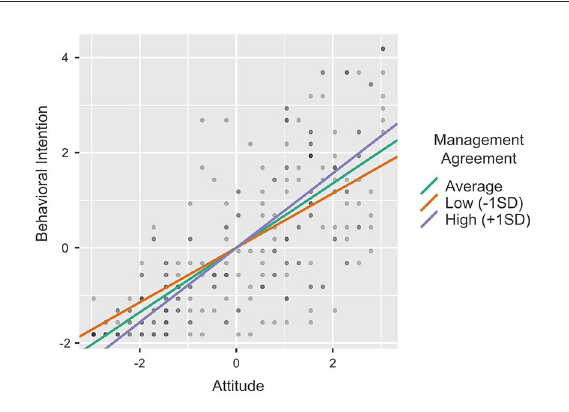
FIGURE5 Single slope plot—Management